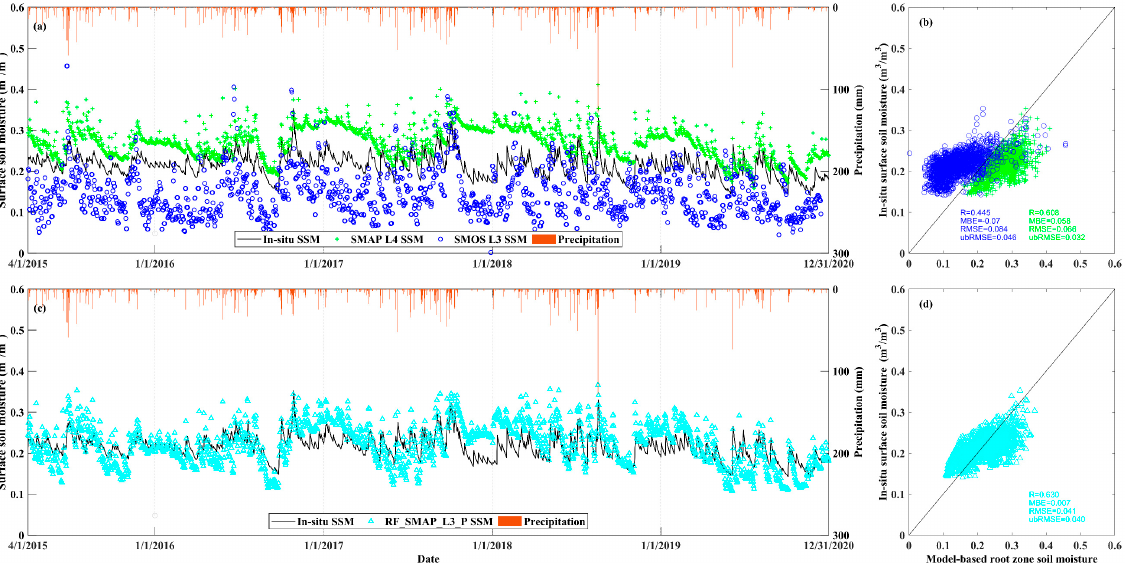
Figure 9. Left panel ( a , c ) shows the time series comparison between in situ SSM and model products (SMAP L4 and SMOS L3 SSM); right panel ( b , d ) is the scatterplots. Blue circle represents SMOS L3 SSM; green cross represents SMAP L4 SSM; cyan triangle represents RF_SMAP_L3_P SSM.